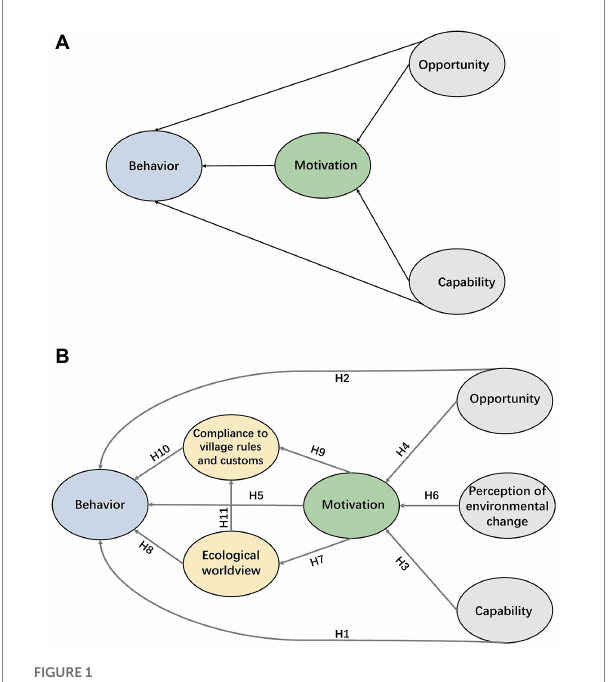
FIGURE 1 COM-B behavior systems (A) and research hypotheses (B)